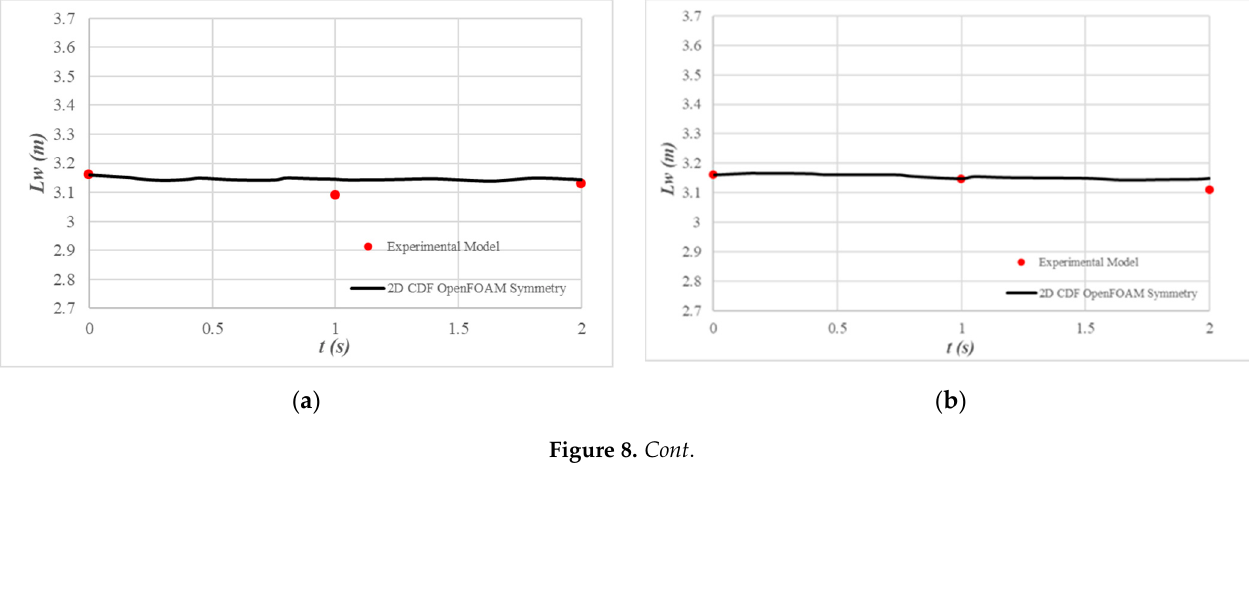
Figure 7. Velocity vectors representative of case B5: ( a ) valve opening at t = 0.50 s; ( b ) valve opening at t = 2.00 s.